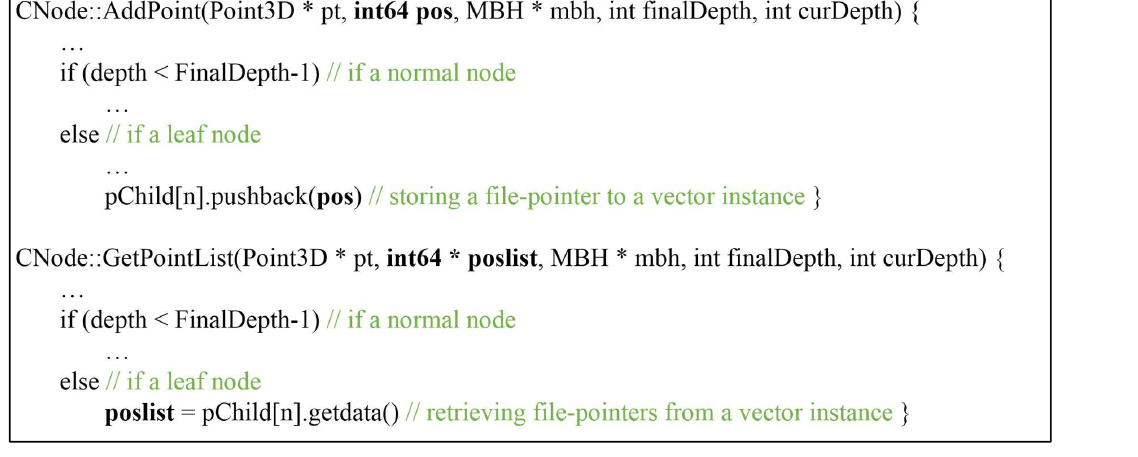
Figure 5. Pseudo codes of the revised AddPoint and GetPointList methods.